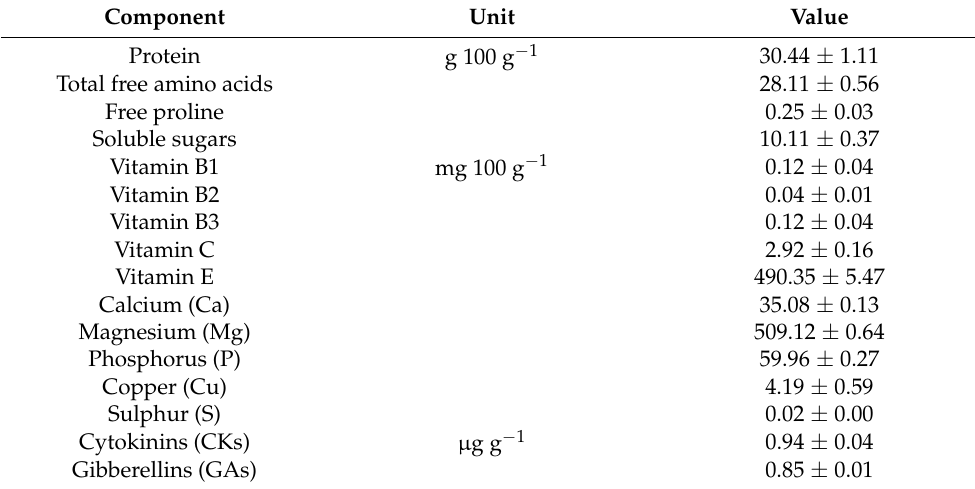
Table 2. Chemical constituents of M. oleifera seed extract (MSE; on a dry weight basis).